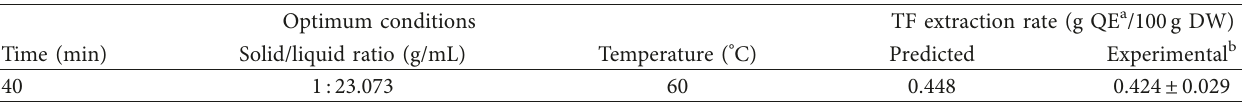
Table 7: Comparison of total flavonoids (TF) extraction rate with or without ultrasound treatment. Solid/liquid ratio Ultrasound treatment (g/mL) General